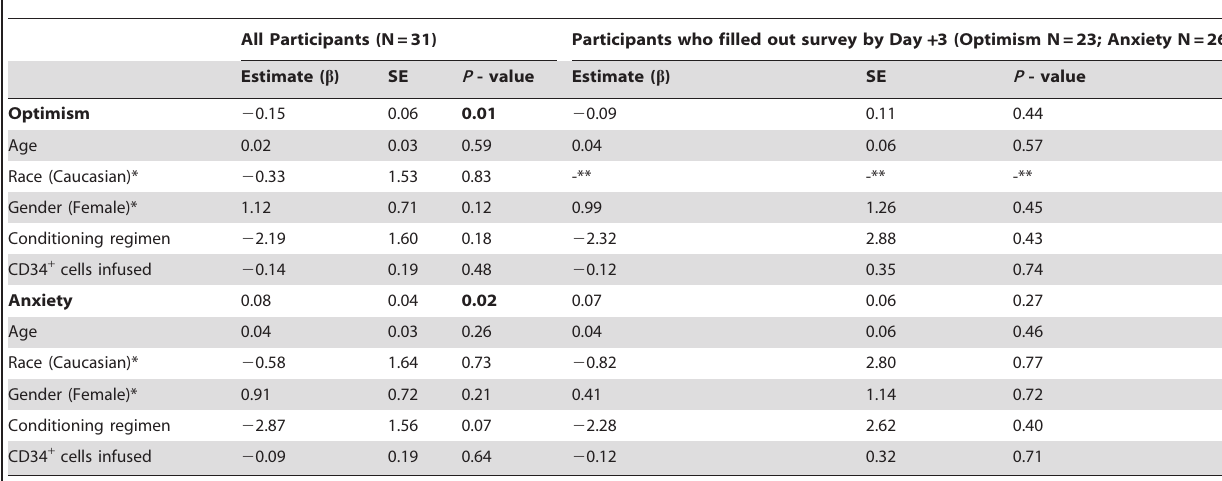
Table 2. Multivariate results of optimism or anxiety and covariates associated with days to neutrophil engraftment in autologous hematopoietic stem cell transplant recipients.